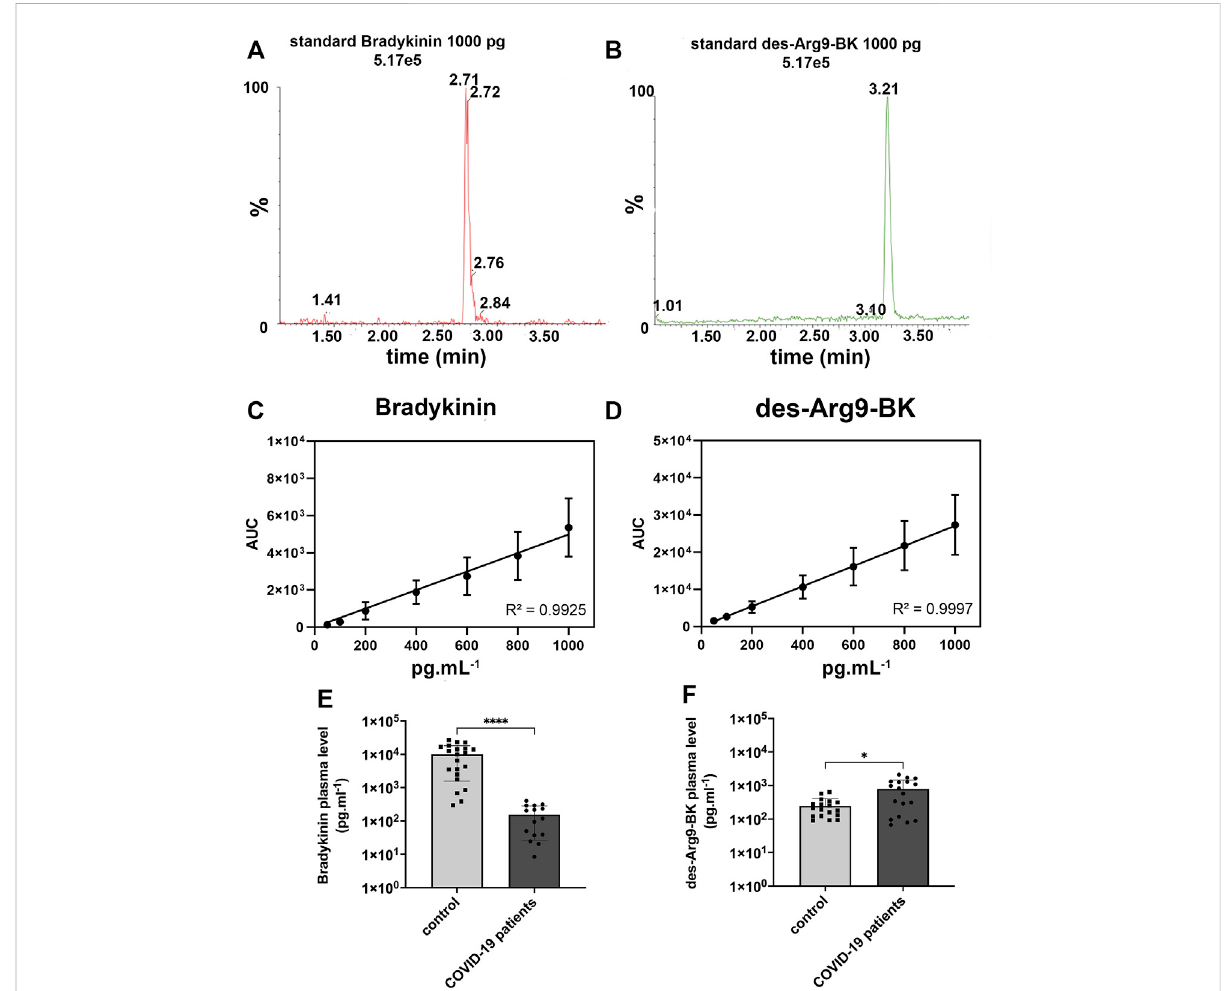
FIGURE 1 Bradykinin and des-Arg 9 -BK concentration in plasma of COVID-19 and control patients. (A) 1000 p g ml − 1 standard chromatogram for bradykinin(BK),expressedinthegraphasrelativepeakabundance(%)bytime. (B) 1000 p g ml − 1 standardchromatogram fordes-Arg 9 -BK,expressed inthegraphasrelativepeakabundance(%)bytime. (C) .CalibrationcurveforBradykininand (D) .des-Arg 9 -BKshowedagoodlinearitywith R 2 > 0.99, (E) . Bradykinin concentration in human plasma was measured by LC-MS/MS from 15 COVID-19 patients (156.4 ± 129.8 p g ml − 1 ) and compared with21controlpatients(9,929±8,368 p g ml − 1 ).ConcentrationofbradykininwaslowerintheplasmaofCOVID-19patients(**** p < 0.0001). Y -axisis in logarithmic scale. (F) . Des-Arg 9 -BK concentration in human plasma was measured by LC-MS/MS from 18 COVID-19 patients (786.3